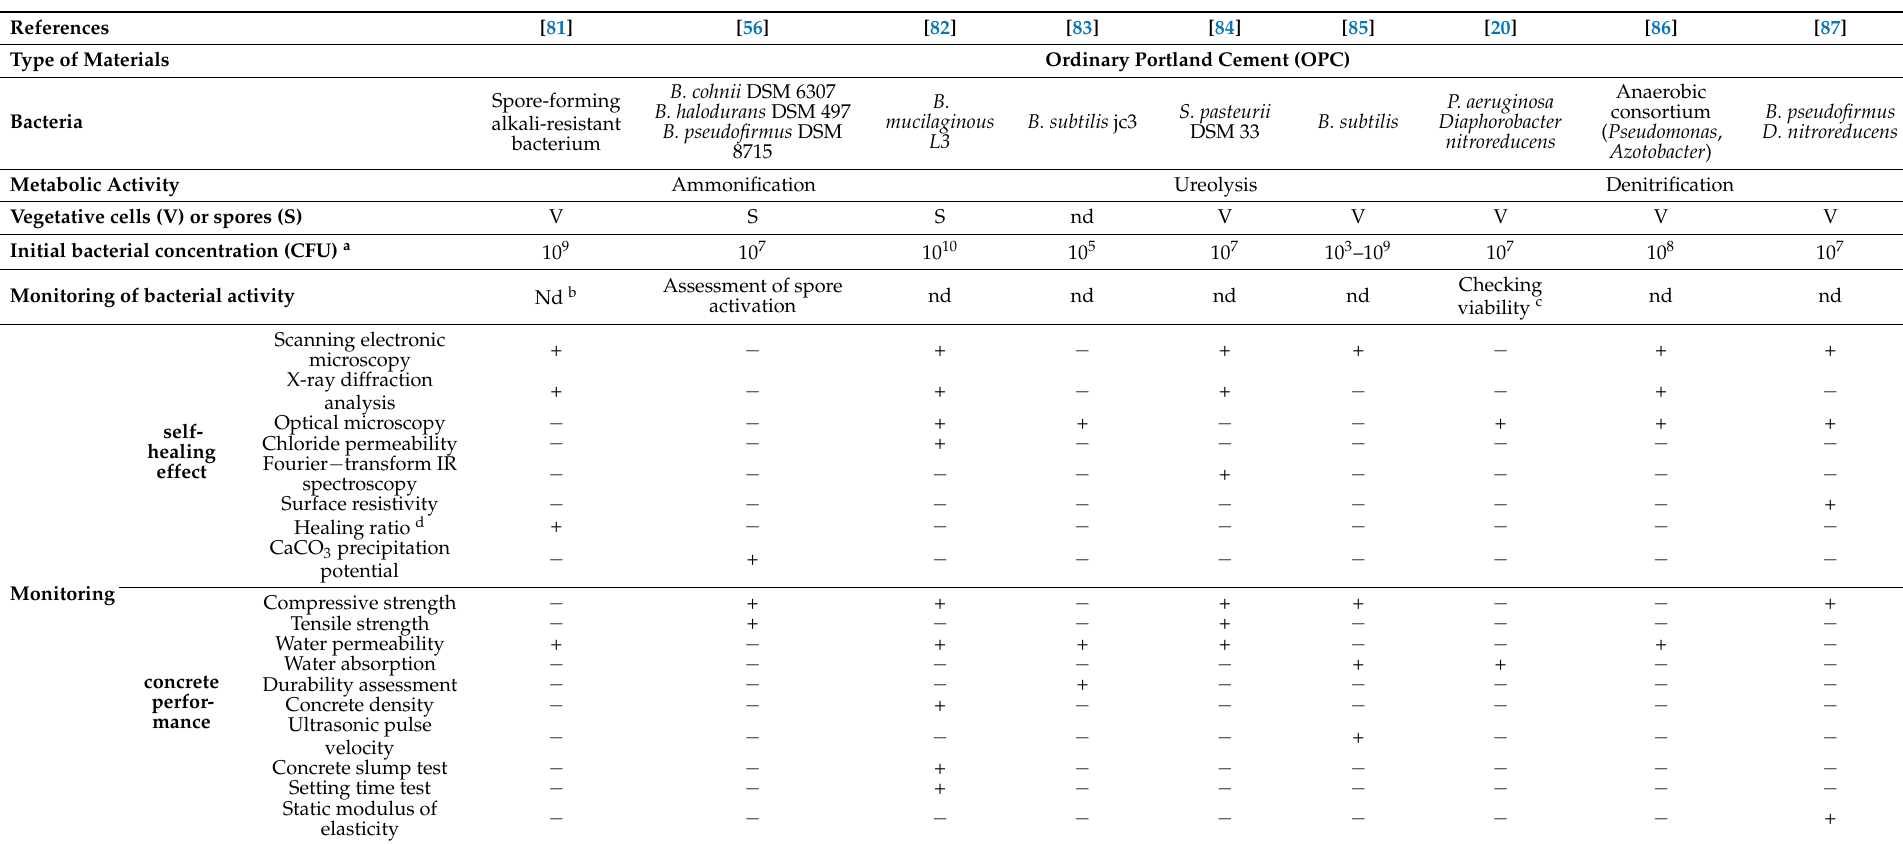
Table 2. Selected examples of different approaches in view of bacteria-relevant parameters and monitoring of the self-healing (SH)